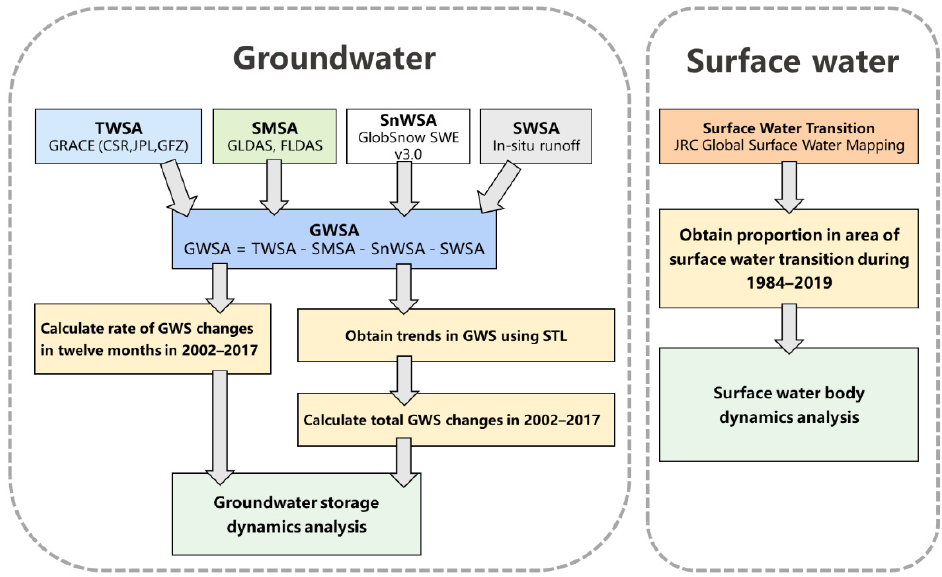
Figure 2. Framework of this study. The SA-ending refers to storage anomalies and snW is snow